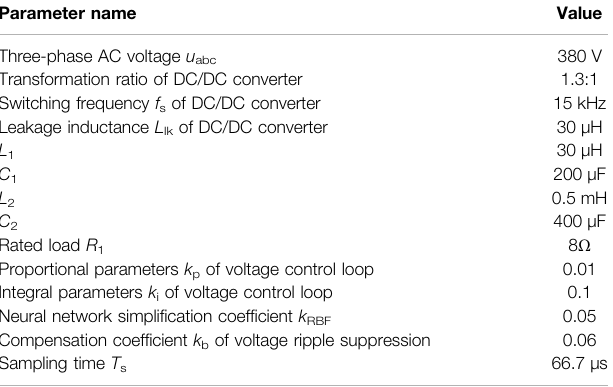
TABLE1| Controlparametersanddeviceparametersoftheexperimentalsystem. Parameter